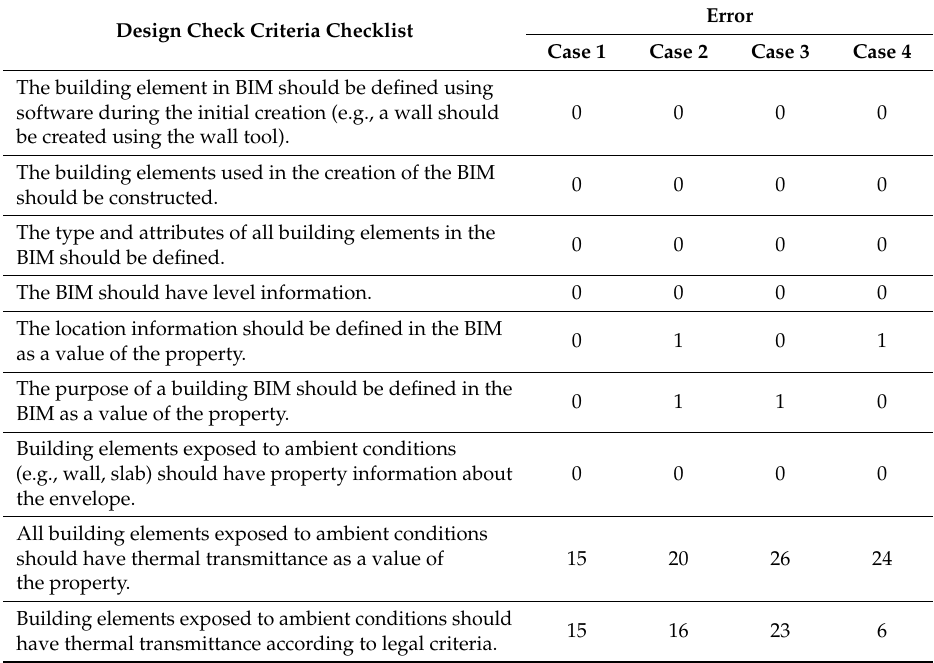
Table 11. The results of quality checks against the design check criteria in case models.